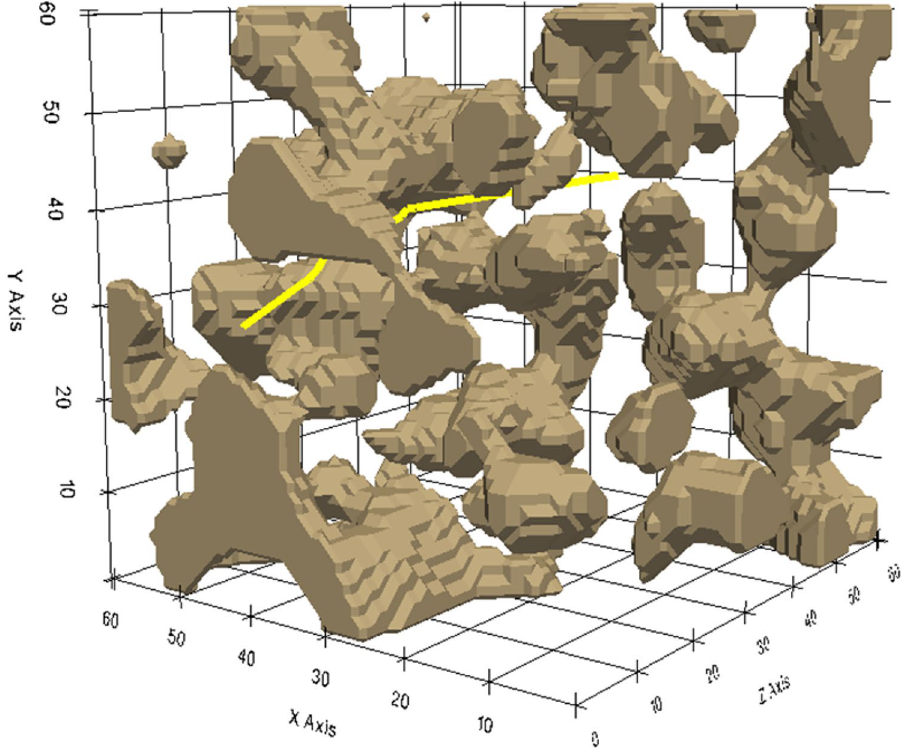
Figure 8. The A-Star algorithm generates the grid map and path in a simplified three-dimensional selected porous